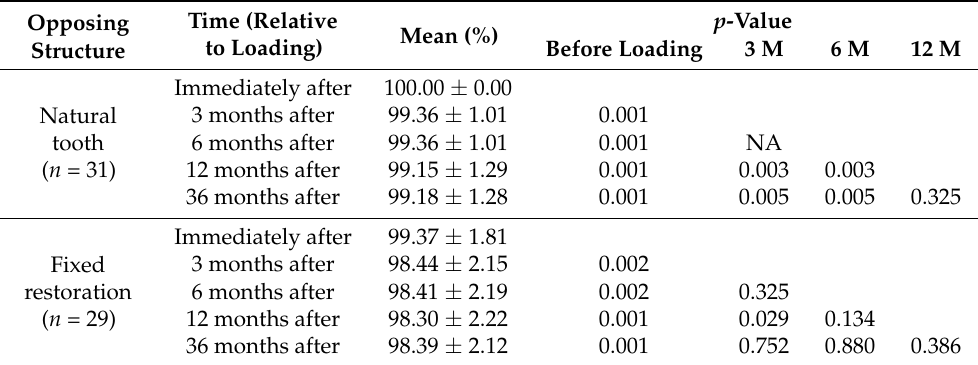
Table 5. Analysis of percentage of bone-to-implant contact of natural teeth and fixed restorations in the opposing arch of the submerged dental implants.